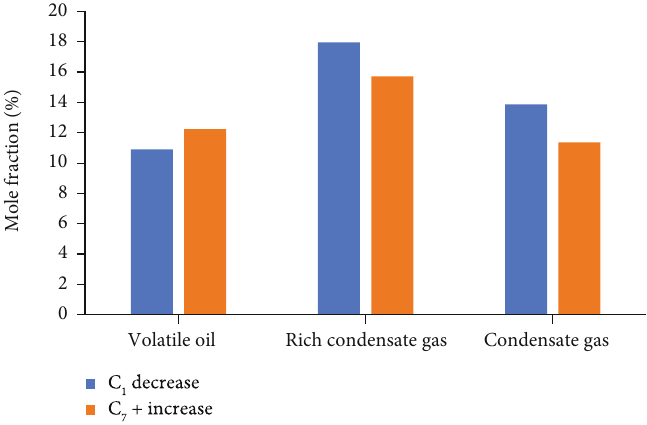
/C Figure 2: C 1 7+ content variation with depth for di